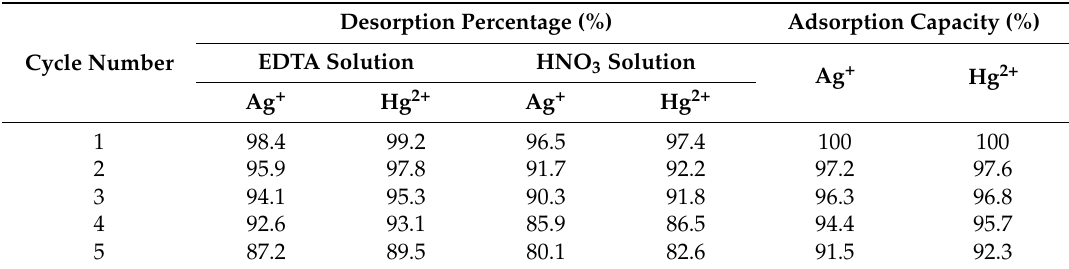
Table 5. Desorption efficiencies (%) and adsorption capacities (%) of Ag + and Hg 2+ on PTT nanoparticles from five adsorption-desorption cycles. Desorption Percentage (%) Adsorption Capacity (%) Cycle Number